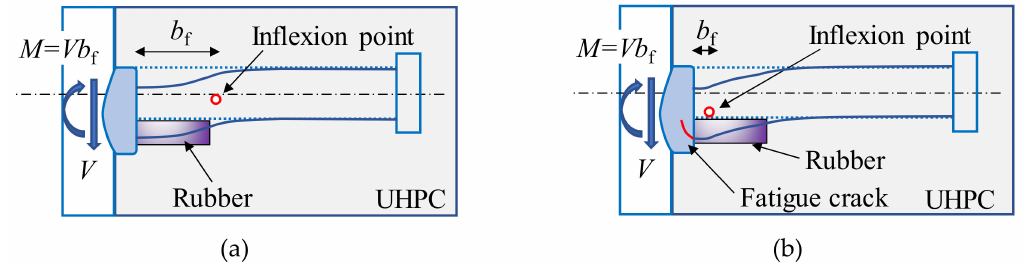
Figure 17. Shear mechanism of rubber-sleeved stud shear connectors: ( a ) before crack initiation; ( b ) after crack initiation.